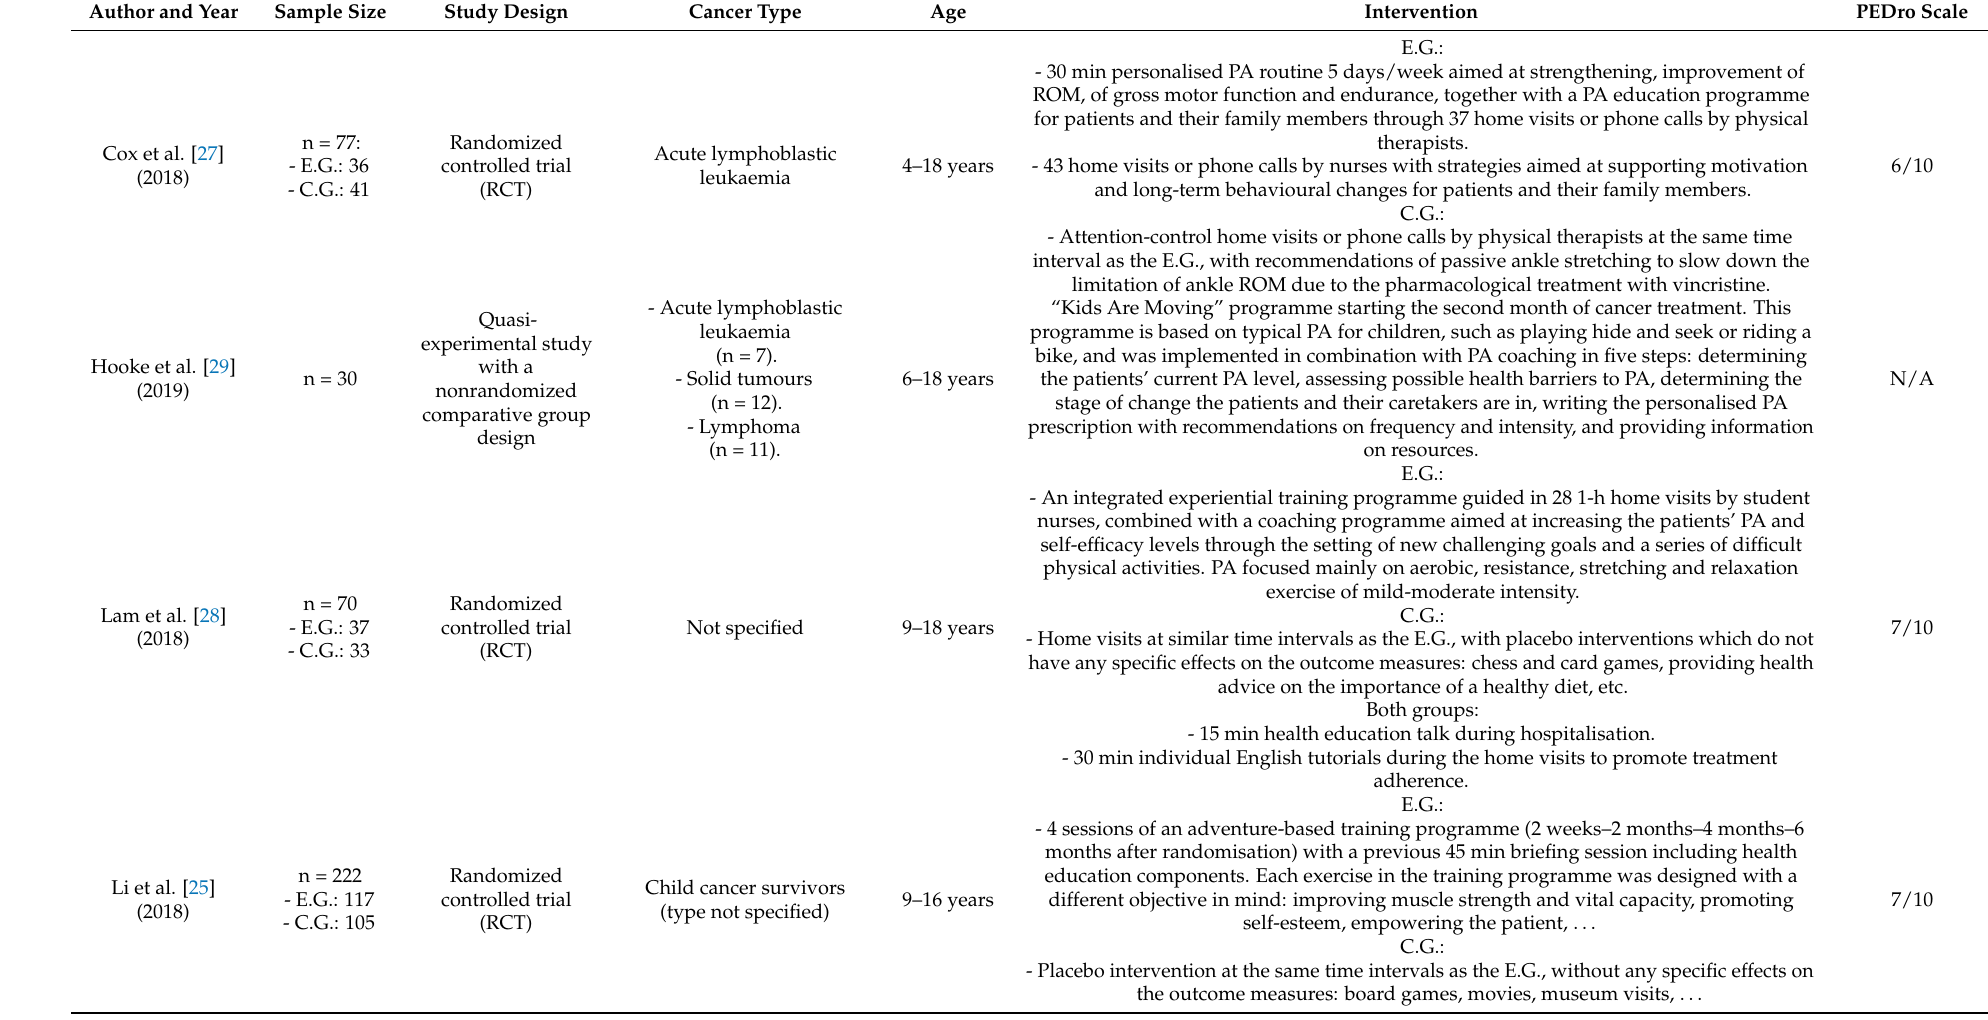
Table 1. Characteristics and methodological quality of the studies analysed according to the PEDro